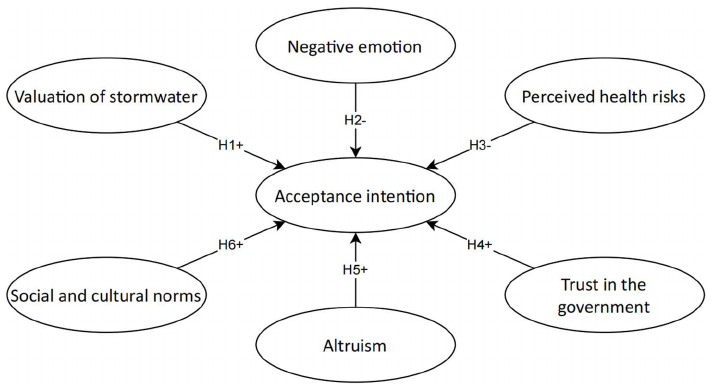
Figure 1. Conceptual model of public acceptance intention towards using recycled stormwater. Note: + positive impact; − negative effect.